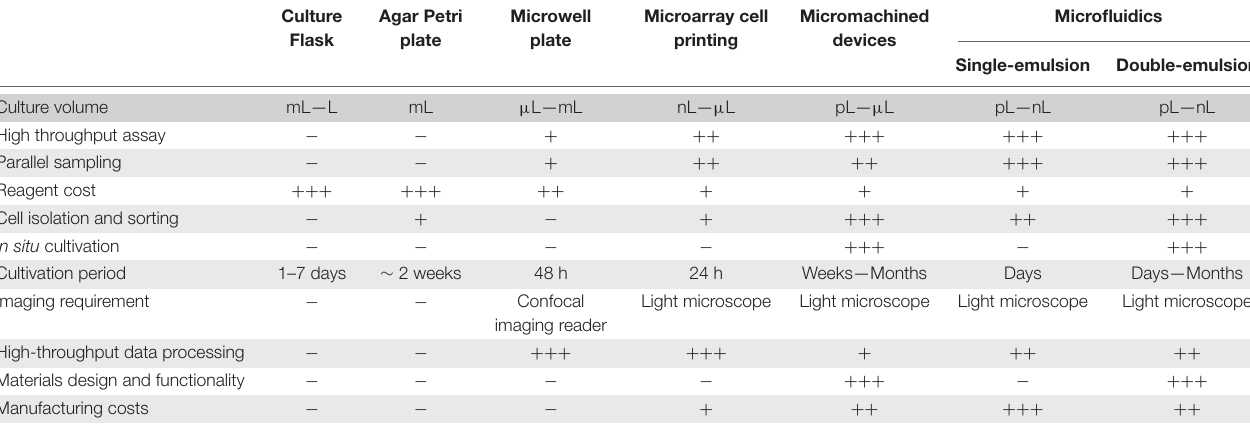
TABLE 1 | A table of comparison of advantages and disadvantages of discussed